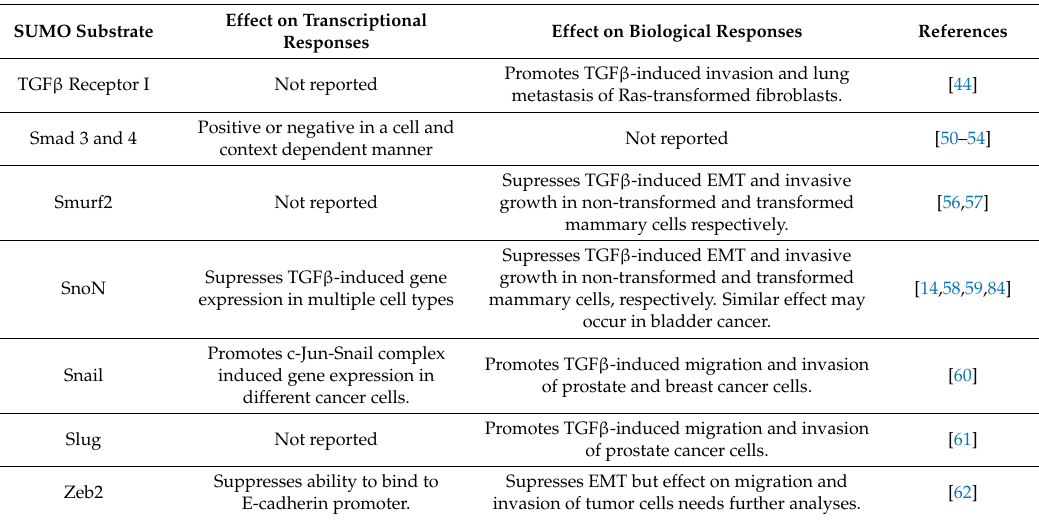
Table 1. Effect of SUMOylation on mediators and regulators of TGF β -induced EMT and cancer cell invasion and